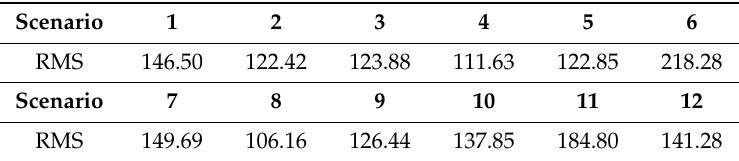
Figure 15. Output curves: (a) The predicted output curve of someday; (b) The predicted output curve of someday and most similar typical scenario output curve.